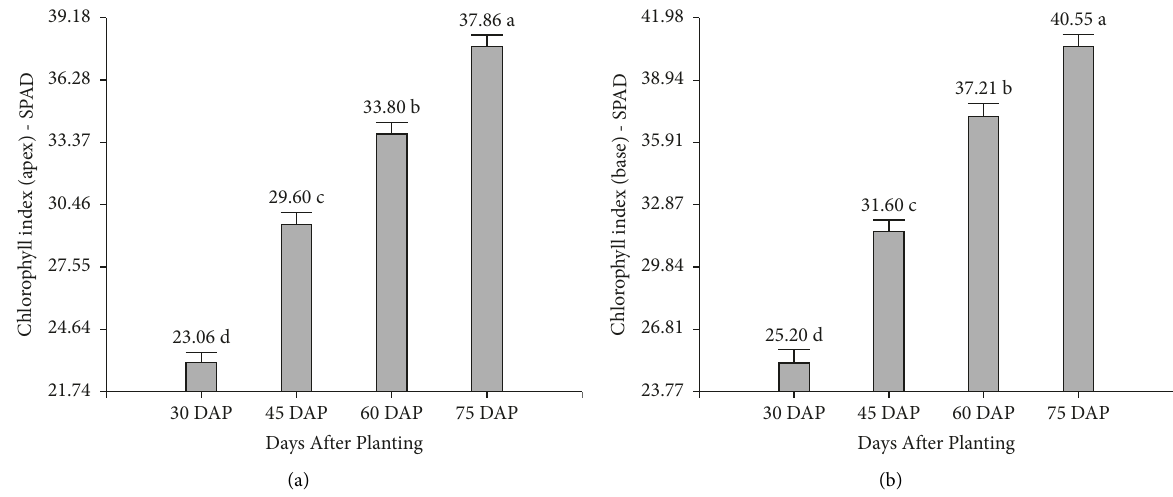
Figure 1: Chlorophyll index (SPAD) for the leaf apex (a) and the leaf base (b) by Days After Planting (DAP). Whiskers show standard deviation and horizontal letters show significant statistical differences. The probability level is 95%